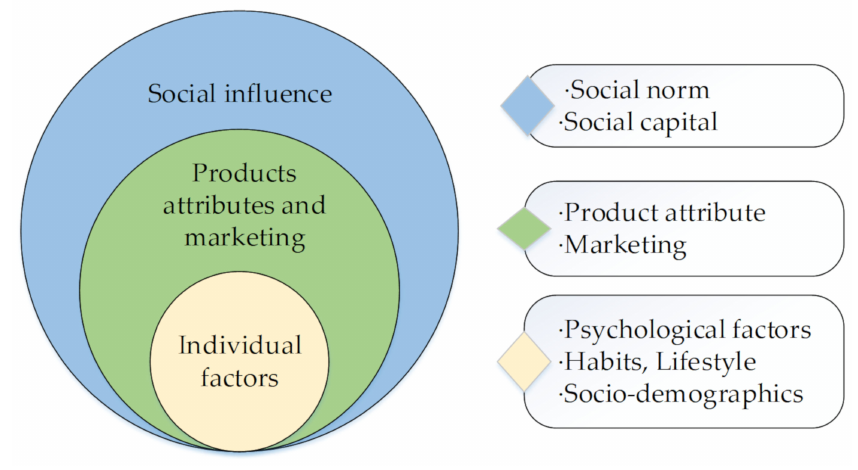
Figure 5. Classification of determinants of green